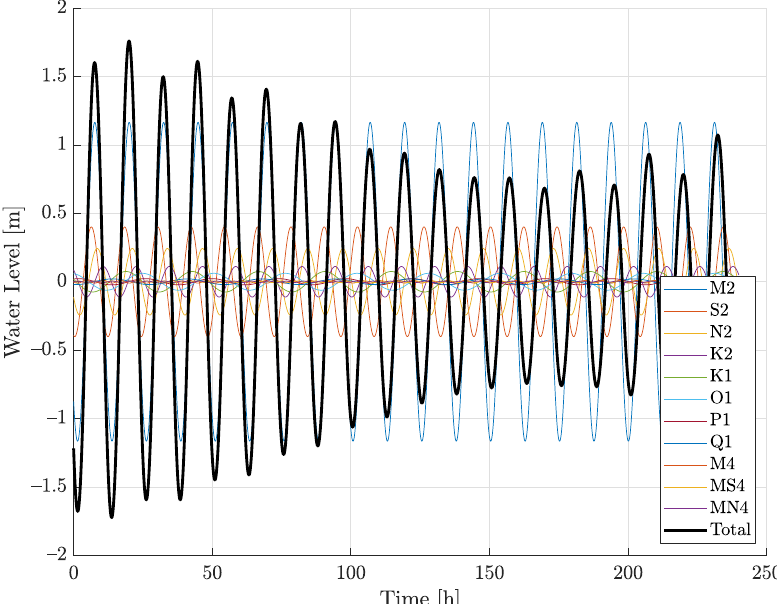
Figure 3. Example of the harmonic constituents used to calculate the water level forcing at the boundary. The plot represents the southwest corner of the